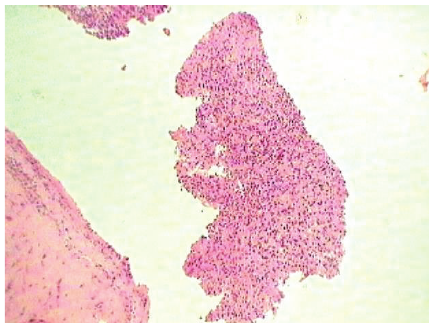
Figure 3: Microphotograph of histopathology of pleural biopsy tissue showing diffuse sheets of round to oval cells with hyper- chromatic nuclei and scant to moderate amount of cytoplasm, focal spindle cells with hyperchromatic nuclei, and focal micropapillae formation, suggestive of a poorly differentiated malignant tumour (H&E stain,